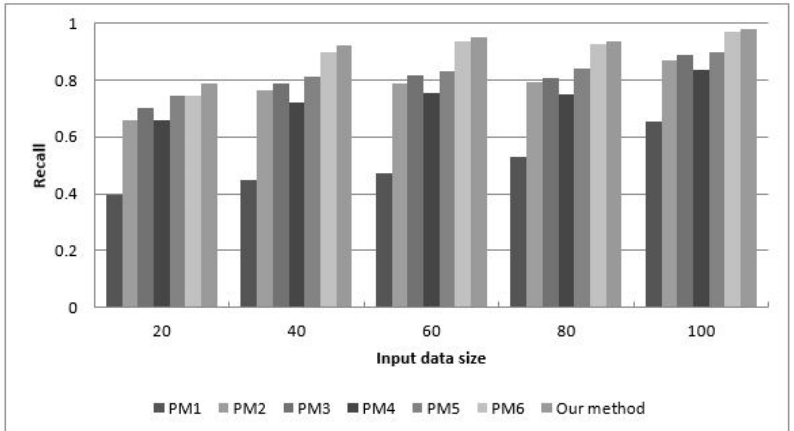
Figure 20. Soundness of RDB2RDF data transformation methods.